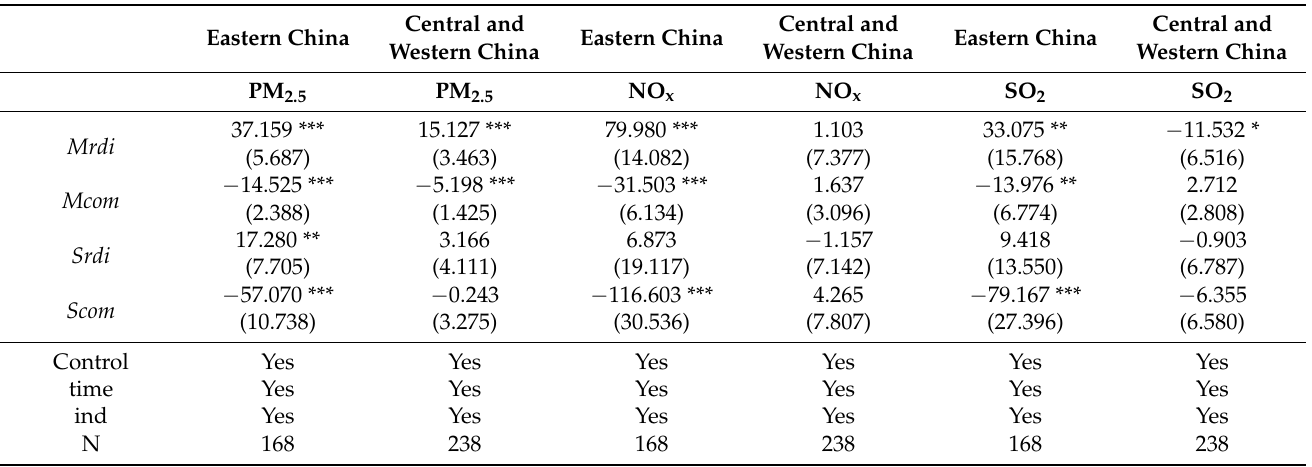
Table 7. Regression of the effect of the heterogeneity of industrial agglomeration on air pollution by